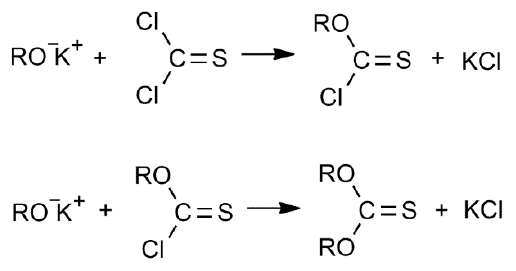
Figure 2. Reaction of thiophosgene with potassium alkoxide.